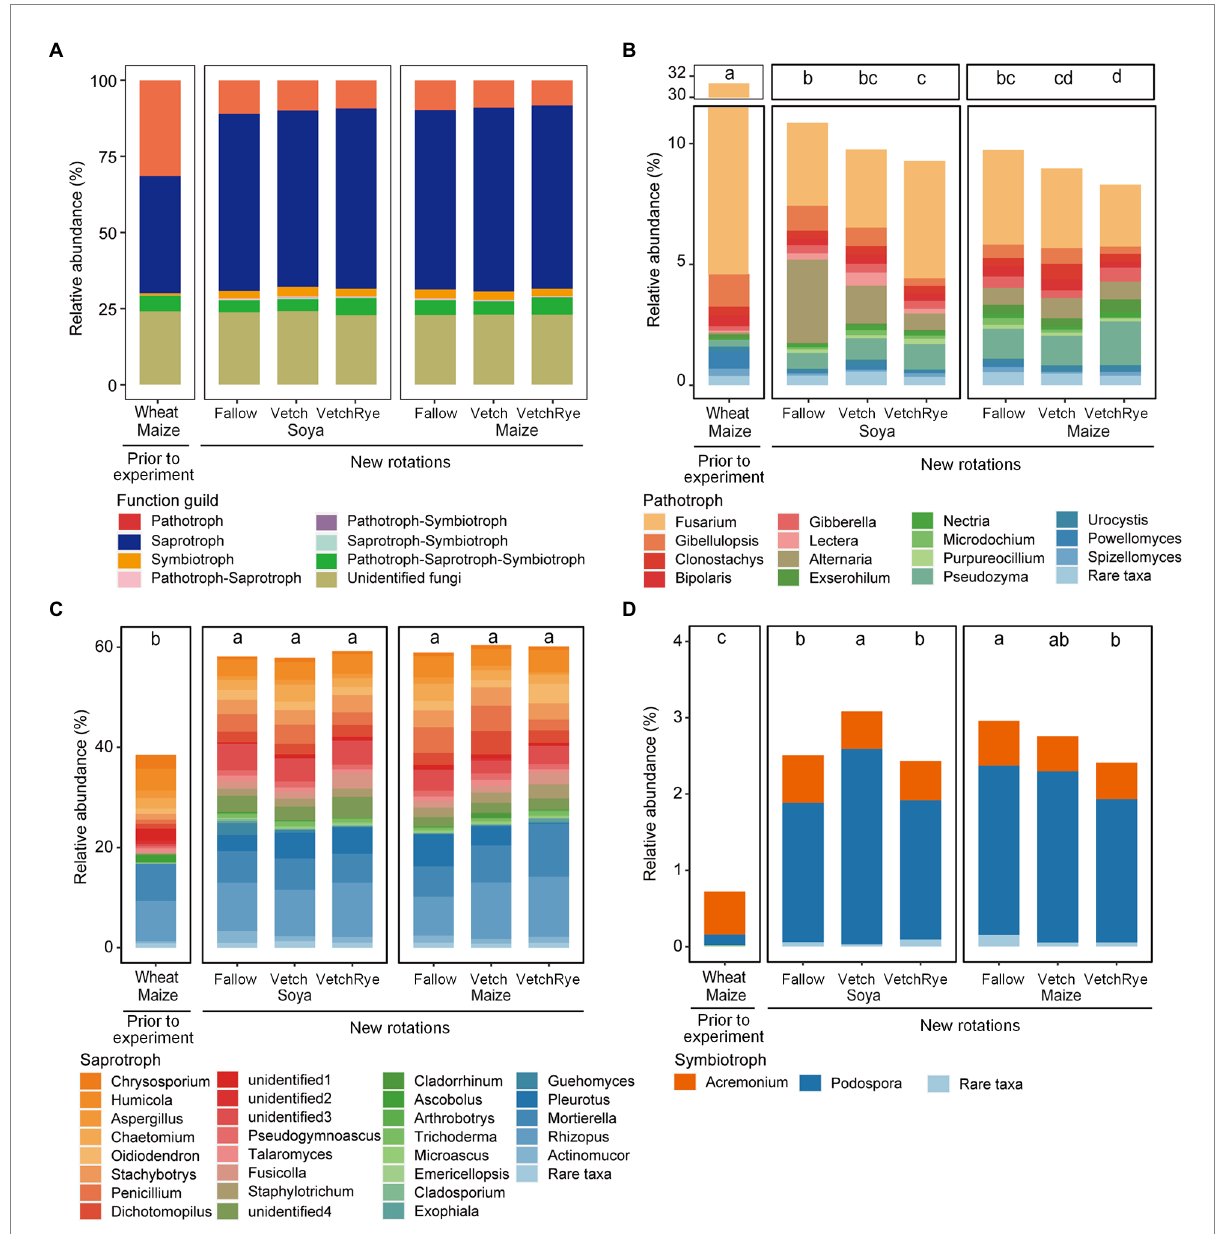
FIGURE 3 Relative abundances of fungal functional guilds (A) and the key fungal genera assigned to pathotrophs (B) , saprotrophs (C) , and symbiotrophs (D) in the new rotation systems compared to those present prior to the experiment. The rare genera that had relative abundances <0.1% are not included. Lowercase letters in the boxes indicate the significant differences among all cropping systems at p ≤